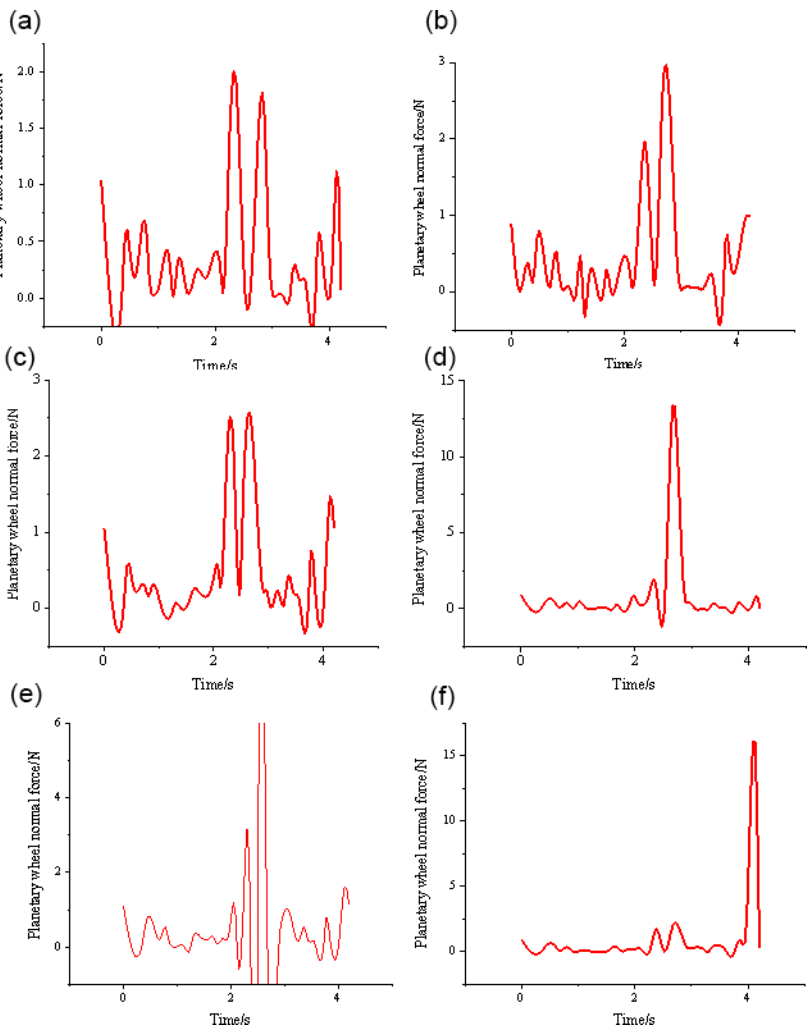
Figure 12. Planetary gear normal force within the error range of different axis degrees. (a) The input shaft is inclined at 0.00000767 ◦ . (b) The input shaft is inclined at 0.0000131 ◦ . (c) The input shaft is inclined at 0.0000186 ◦ . (d) The input shaft is inclined at 0.0000238 ◦ . (e) The input shaft is inclined at 0.0000289 ◦ . (f) The input shaft is inclined at 0.0000344 ◦